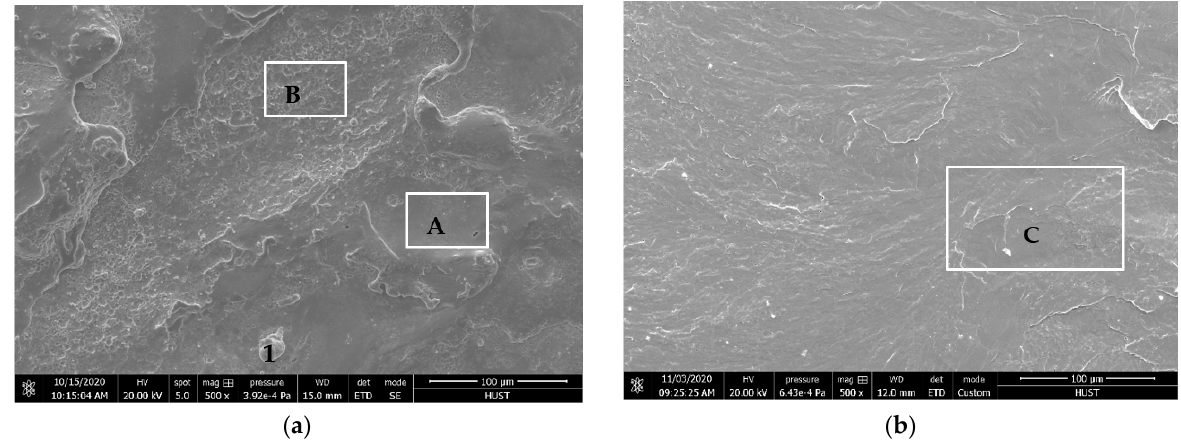
Figure 6. SEM images of laser clad La 2 Zr 2 O 7 /NiCoCrAlY coating and Inconel 718 substrate after corrosion in 3.5 wt.% NaCl solution: ( a ) Inconel 718 substrate, ( b ) laser clad coating. (A, B, and C represent the different positions of the corroded specimen.) Table 5. EDS results of corroded surfaces of the Inconel 718 substrate and the laser clad specimen (at.%). Table 6. Pilling–Bedworth ratios of different metal oxides